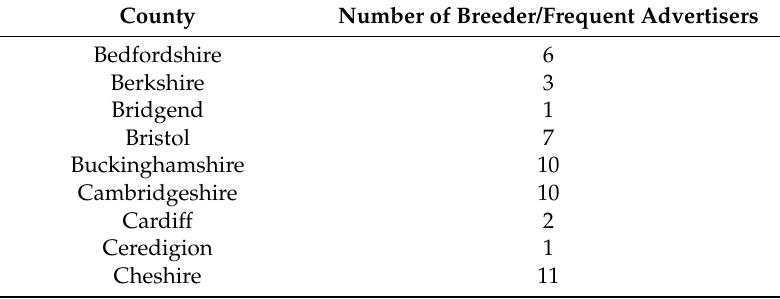
Table A1. The number of self-declared rabbit breeders/frequent advertisers on Pets4Homes in the one-month period studied shown by